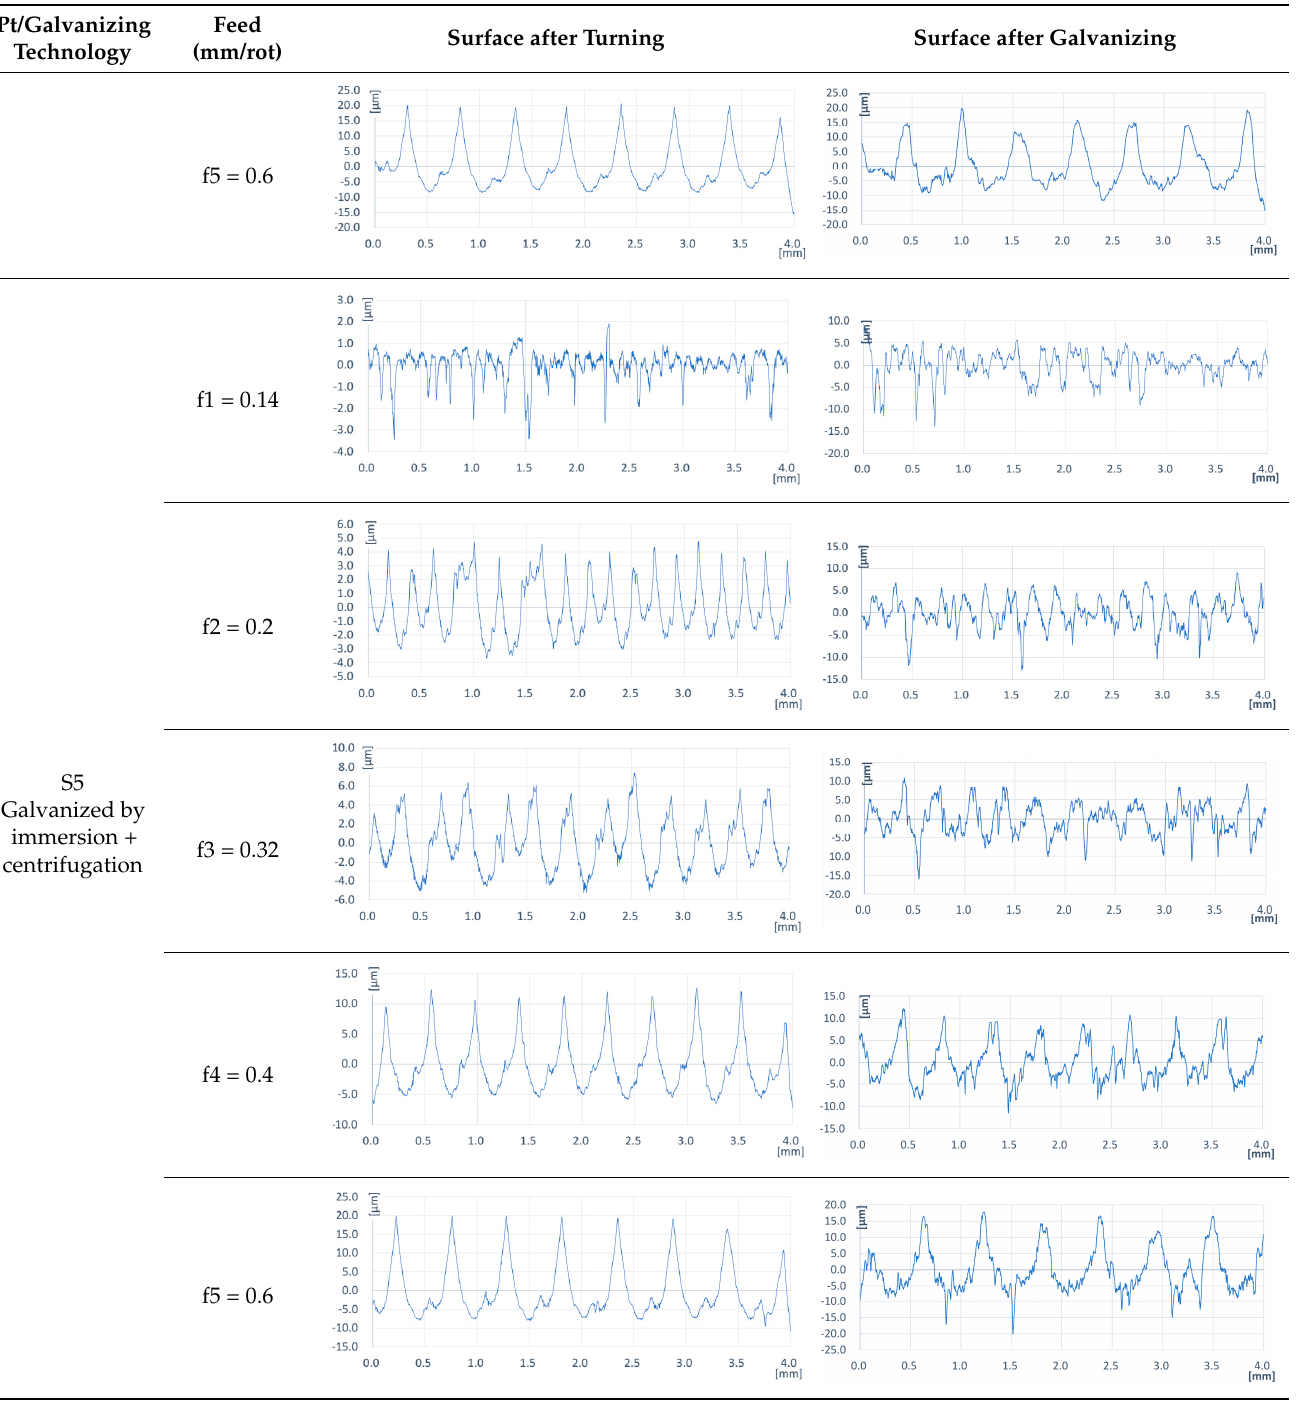
By analyzing the pro fi lograms in the case of the roughness of the fi rst 2 samples, it was found that zinc completely covers the pro fi le as a result of turning, and a di ff